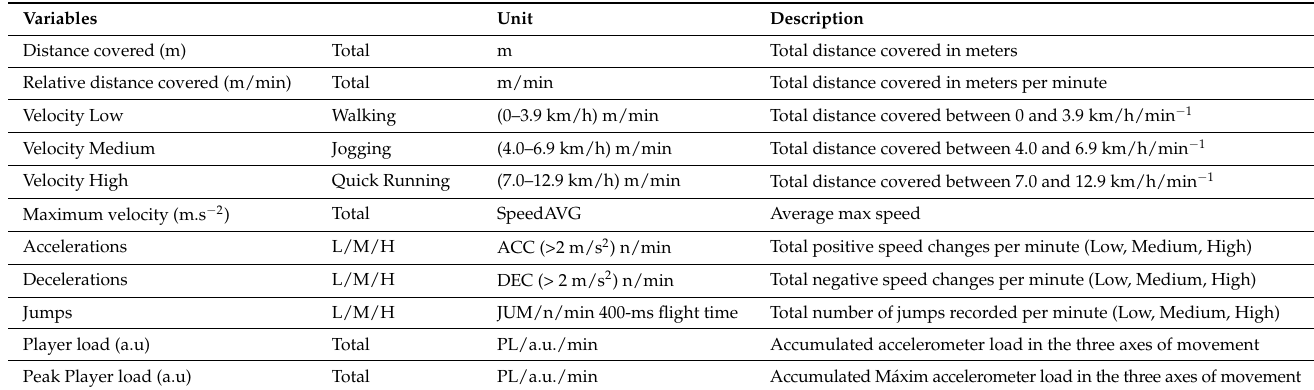
Table 1. Descriptions of positional